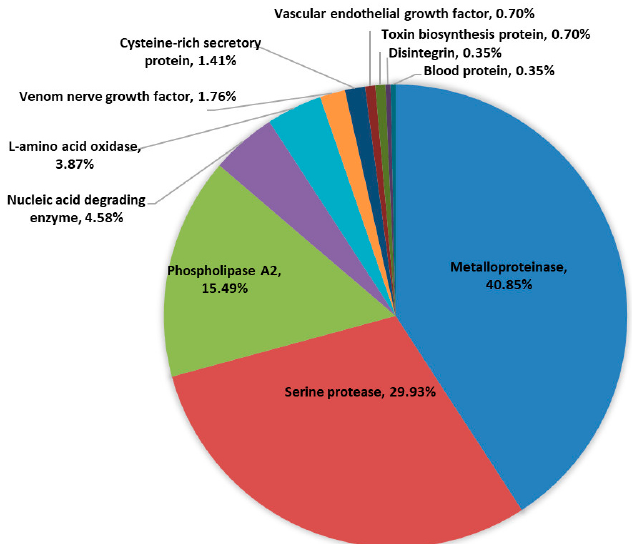
Figure 5. The classification of Protobothrops kelomohy venom